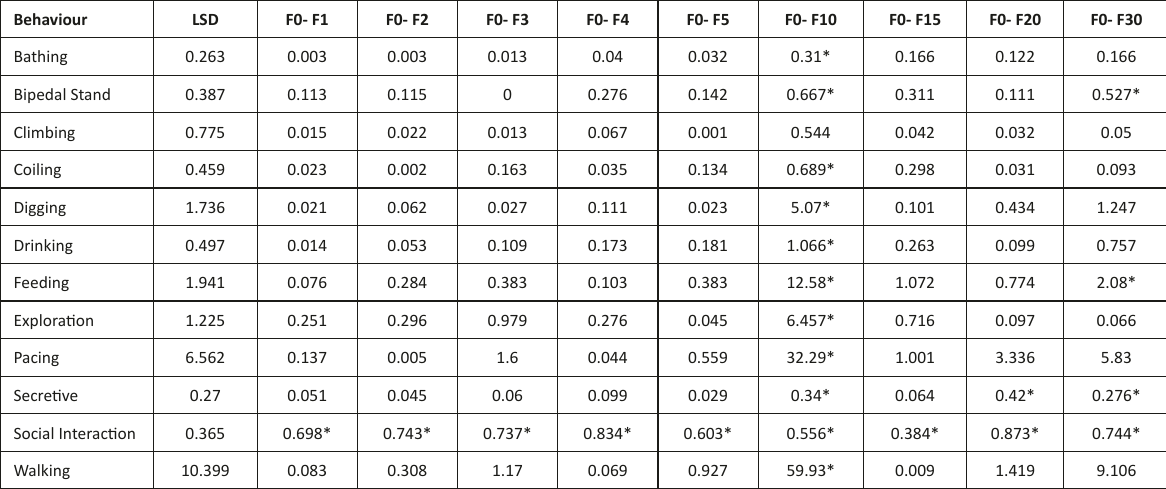
Table 6. Value for LSD (Fisher’s Least Significant Difference) and group mean difference between focal (F0) and instantaneous behavioural sampling (F1, F2 etc.). ‘*’= Value of ‘mean differences’ >LSD.